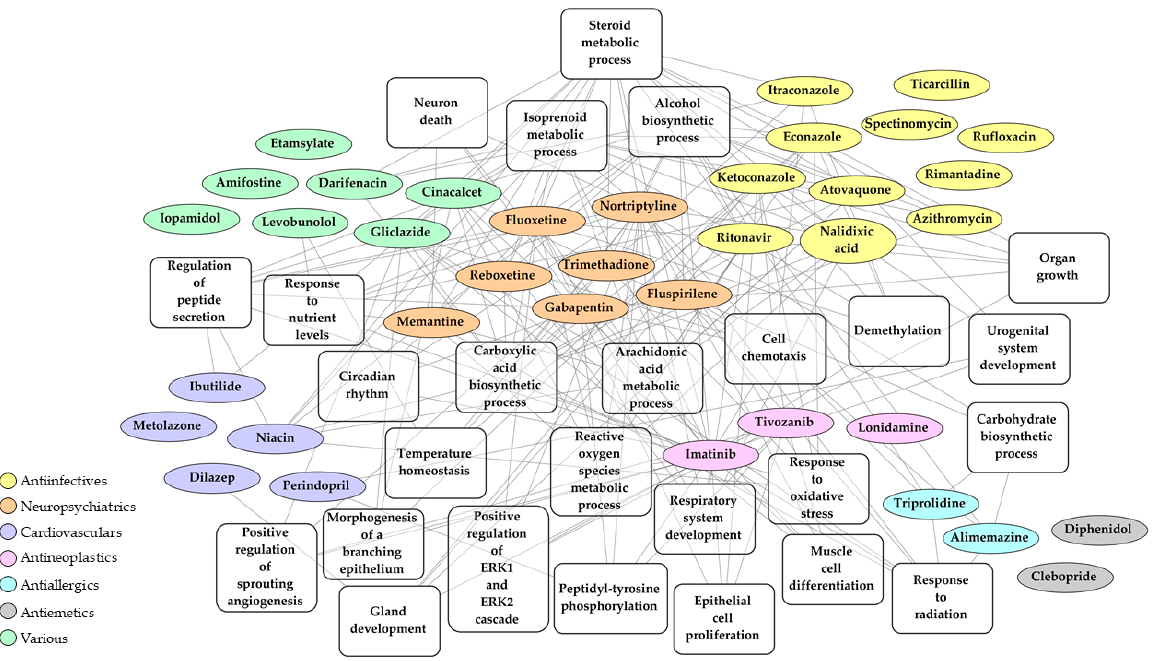
Figure 4. Network of 37 repurposable drug candidates that may reverse SARS-CoV-2 transcriptomic signature based on current therapeutic indication and key biological pathways.